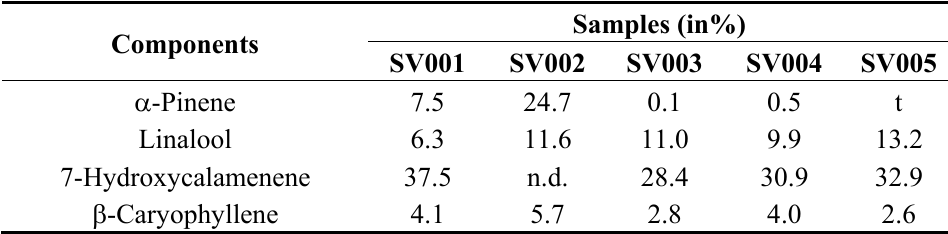
Table 1. Main components from C. cajucara essential oils.